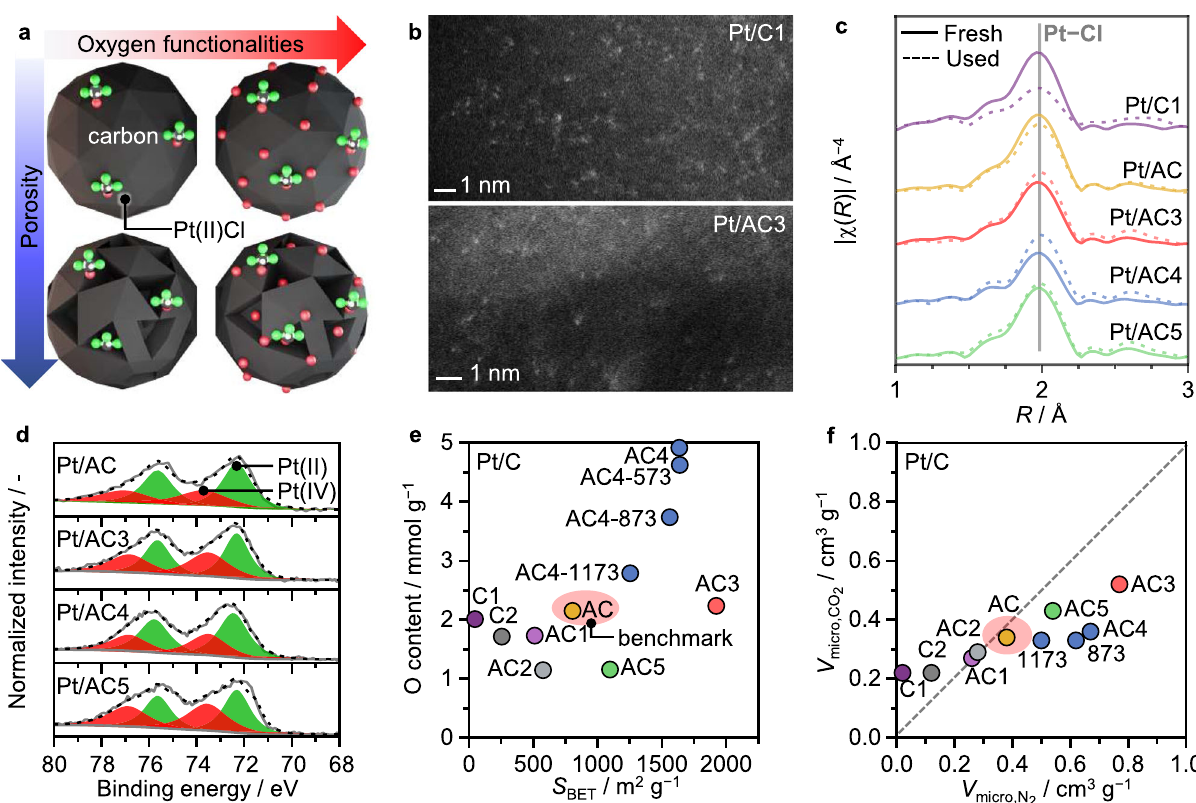
Fig. 1 Preparation and characterization of the Pt/C catalysts. a Synthetic strategy to control the porous properties and surface functionalization of the carbon support, while preserving the structure of the active platinum single-atom site in the catalytic material. b STEM, c Pt L 3 EXAFS, d normalized Pt 4 f XPS, e overview of the total oxygen content, surface area, and f micropore volume of the Pt/C (Supplementary Table 4), while the ratio between C – O and C = O functionalities remained rather constant (~3:2 ratio of C – O to C = O groups) in all samples (Supplementary Table 9).